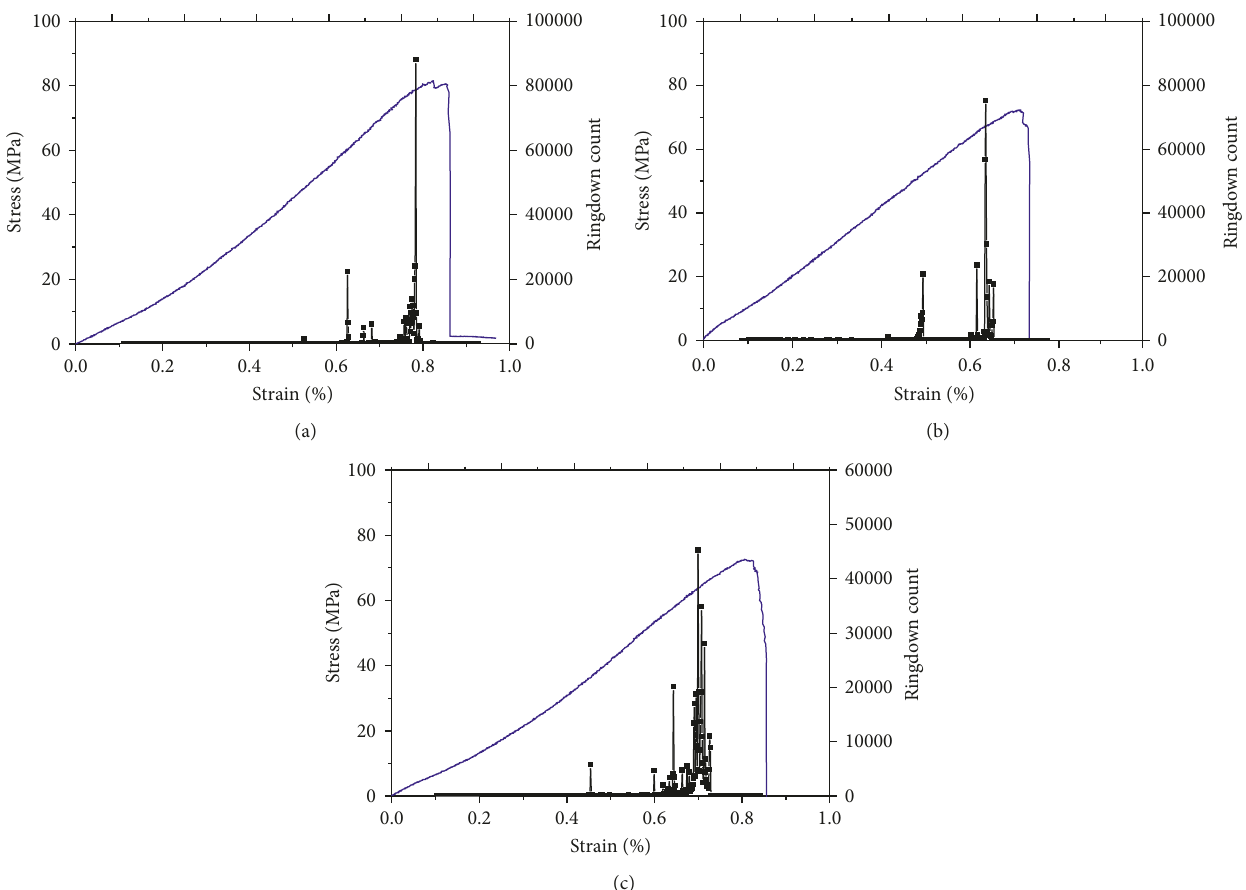
Figure 3: Acoustic emission characteristics for different failure types: (a) acoustic emission for tensile failure, (b) acoustic emission for combination failure, and (c) acoustic emission for shear